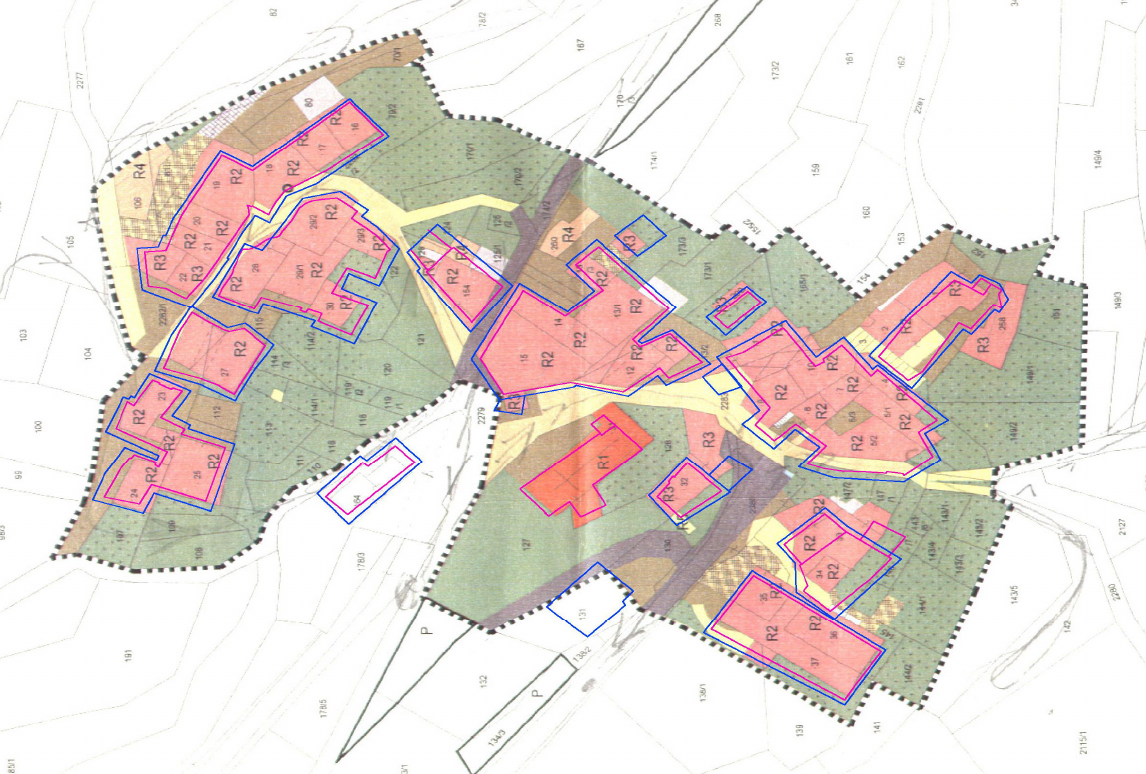
Figure 13: The superimposed building contours (derived from the laser scanning data) onto the existing map of the village. Remarkable shifts and differences are clearly